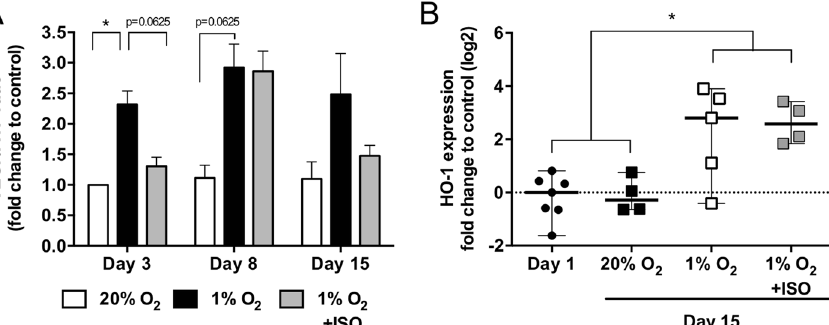
Figure 7. Hypoxic signature of neonate pig islets (NPIs) in O 2 balanced BAPs. Alginate encapsulated NPIs (3000 IEQ/150 µL) were cultured for 3, 8, and 15 days under 20% O 2 (20% O 2 , positive control, white bar) or 1% O 2 condition without O 2 strategy (1% O 2, negative control, black bar) or with the innovative strategy of oxygenation (ISO) composed of silicone-CaO 2 disk and 500 µg/mL HEMOXCell by alginate (1% O 2 + ISO, grey bars). Fold change in VEGF secretion by total metabolic activity (AU/RLU) of encapsulated NPIs compared to the control cultured for 3 days under 20% O 2 without O 2 strategy. ( B ) Relative quantitative RT-PCR expression analysis of Heme oxygenase (HO-1) of decapsulated NPIs cultured for 15 days within BAPs (n = 4–7). Results from independent experiments (n = 4–7) are expressed as mean ± SEM. *p < 0.05 (Non-parametric Wilcoxon apparatus